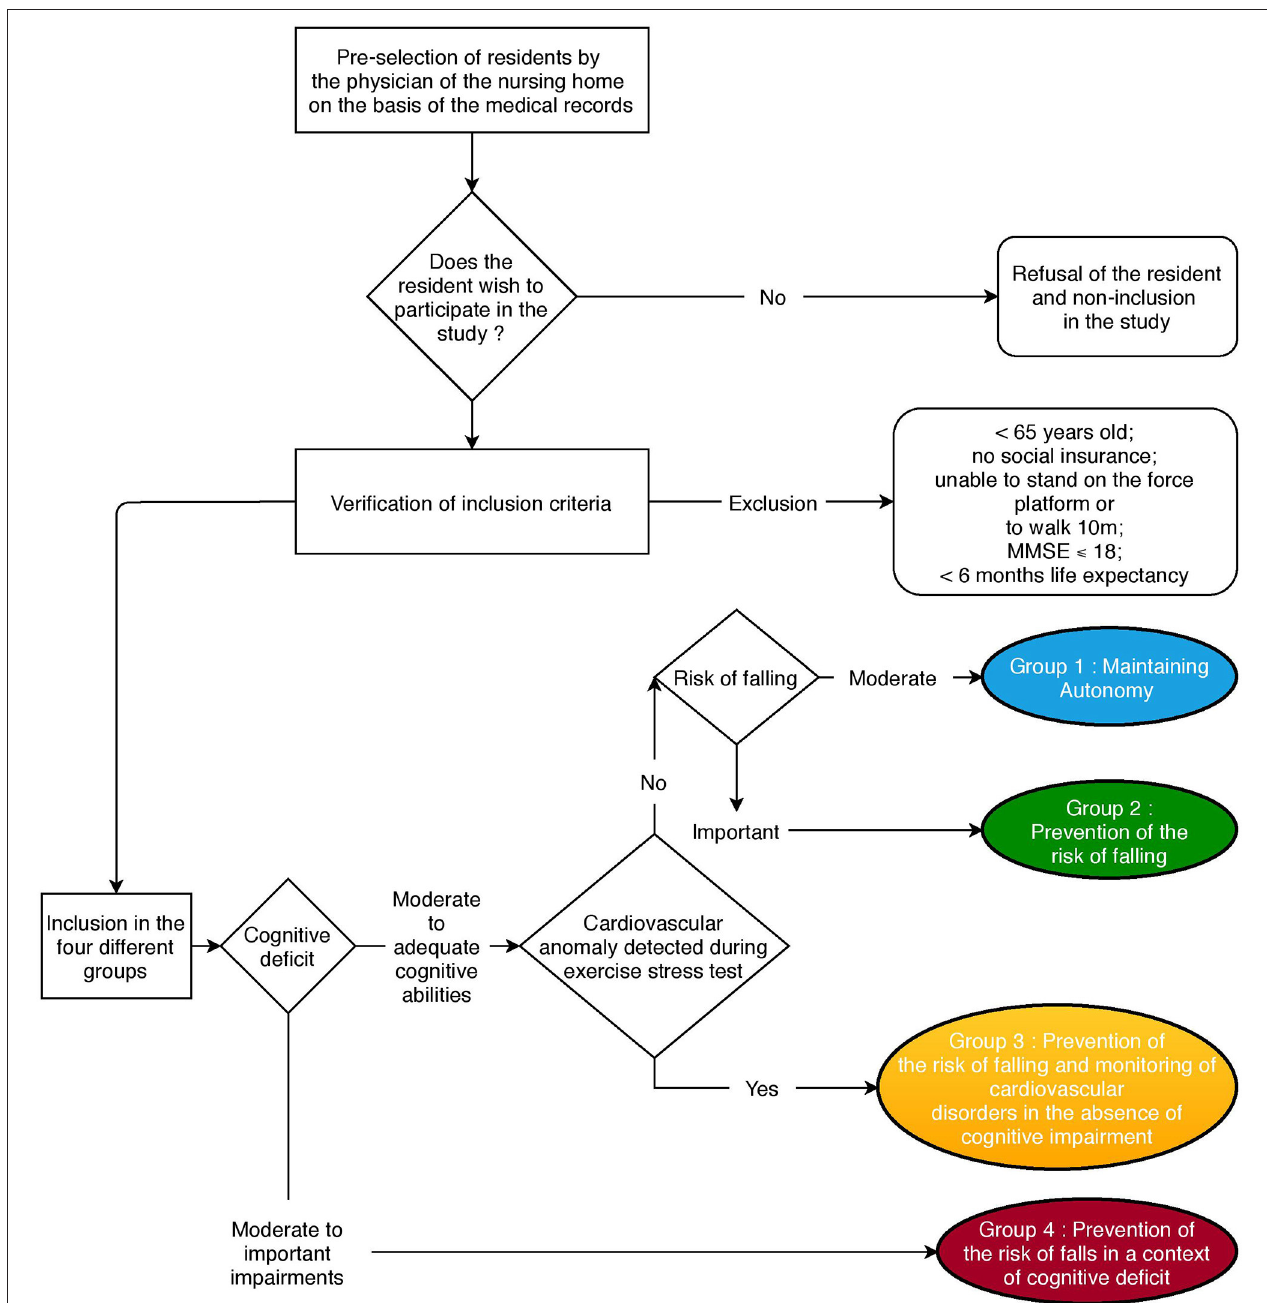
FIGURE 2 | Flowchart of the distribution of residents in the different groups of APA after checking the adequacy of the selection